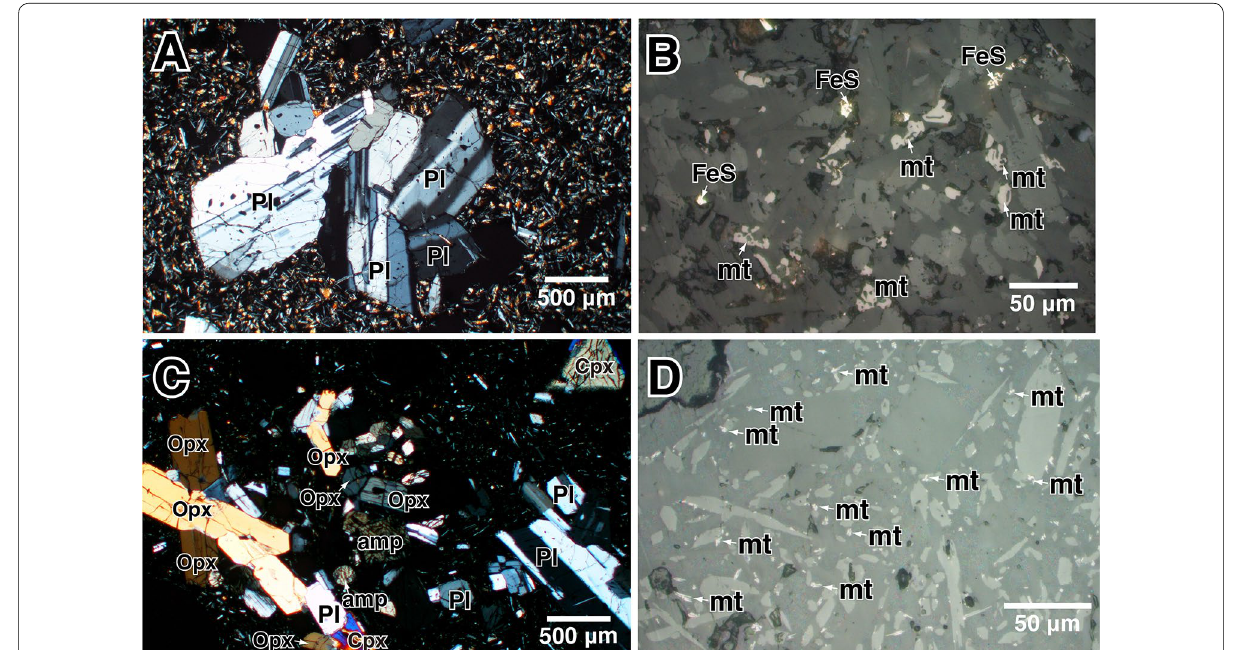
Fig. 3 Photomicrographs of the studied fresh volcanic rock samples from the Irabu knolls of the Okinawa Trough; 6K#562R1 and 6K#569R4‑2. A Plagioclase (Pl) glomeroporphyritic and intergranular groundmass texture in the 6K#562R1. Under transmitted crossed polarized light (CPL). B Titanomagnetite (mt) and pyrite (FeS) grains in the 6K#562R1. Under reflected plane‑polarized light (PPL). C Plagioclase (Pl), orthopyroxene (Opx), amphibole (amp), and clinopyroxene (Cpx) glomeroporphyritic and intersertal groundmass texture in the 6K#569R4‑2. Under transmitted CPL. D Titanomagnetite (mt) grains in the 6K#569R4‑2. Under reflected